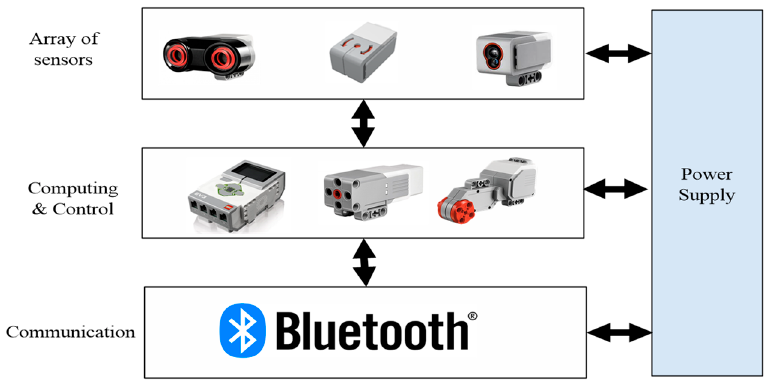
Figure 6. Lego EV3 robot architecture. Table 1. General specification parameters for the ultrasonic sensor.